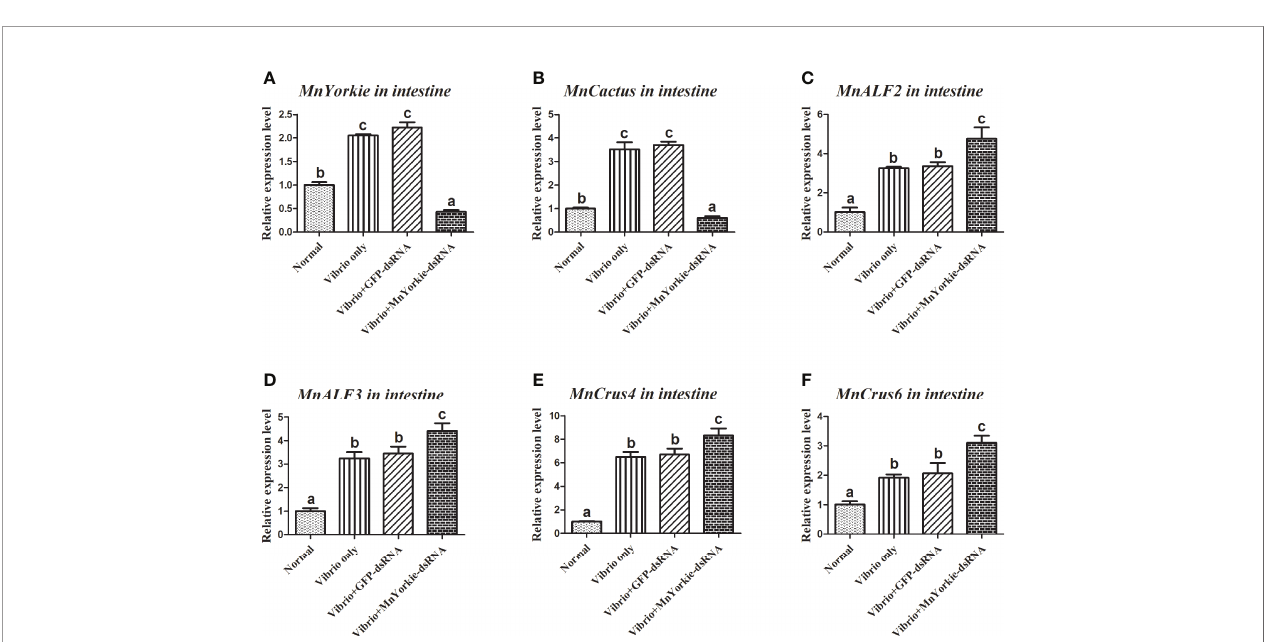
FIGURE 10 | Analysis of MnCactus and four immune-related genes expression levels after MnYorkie RNAi. (A) Ef fi ciency of RNAi detected by RT-qPCR in intestine at 36 h post of MnYorkie -dsRNA and V. parahaemolyticus injection. The mRNA expression levels of MnCactus (B) , MnALF2 (C) , MnALF3 (D) , MnCrus4 (E) , MnCrus6 (F) were detected by RT-qPCR at 24 h injection of V. parahaemolyticus post MnYorkie RNAi. Signi fi cance differences were compared between the normal group to other treated groups at the same time point. Signi fi cant differences were marked with different letters (a, b, c,